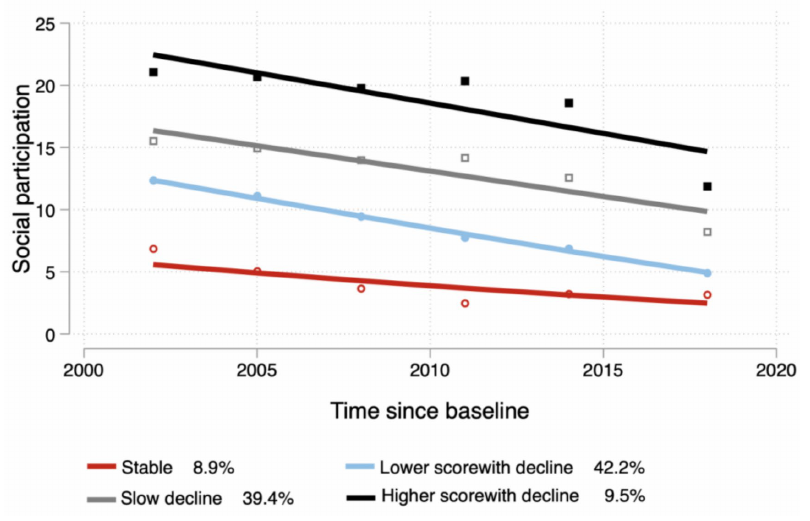
Figure 1. Trajectories in social participation.